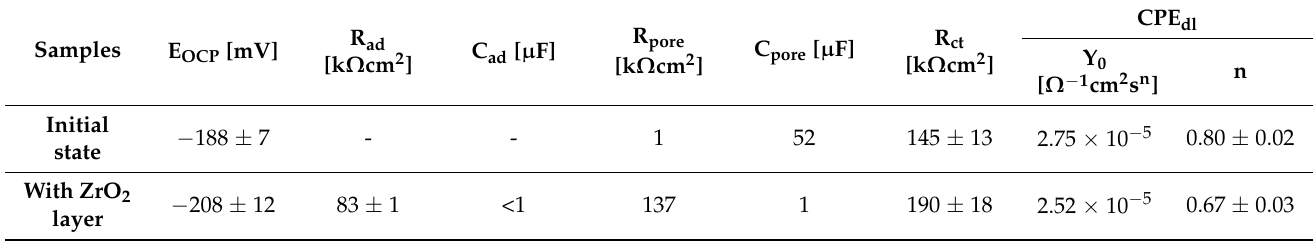
Table 5. Results of impedance tests for samples in the initial state and with ZrO 2 layer.